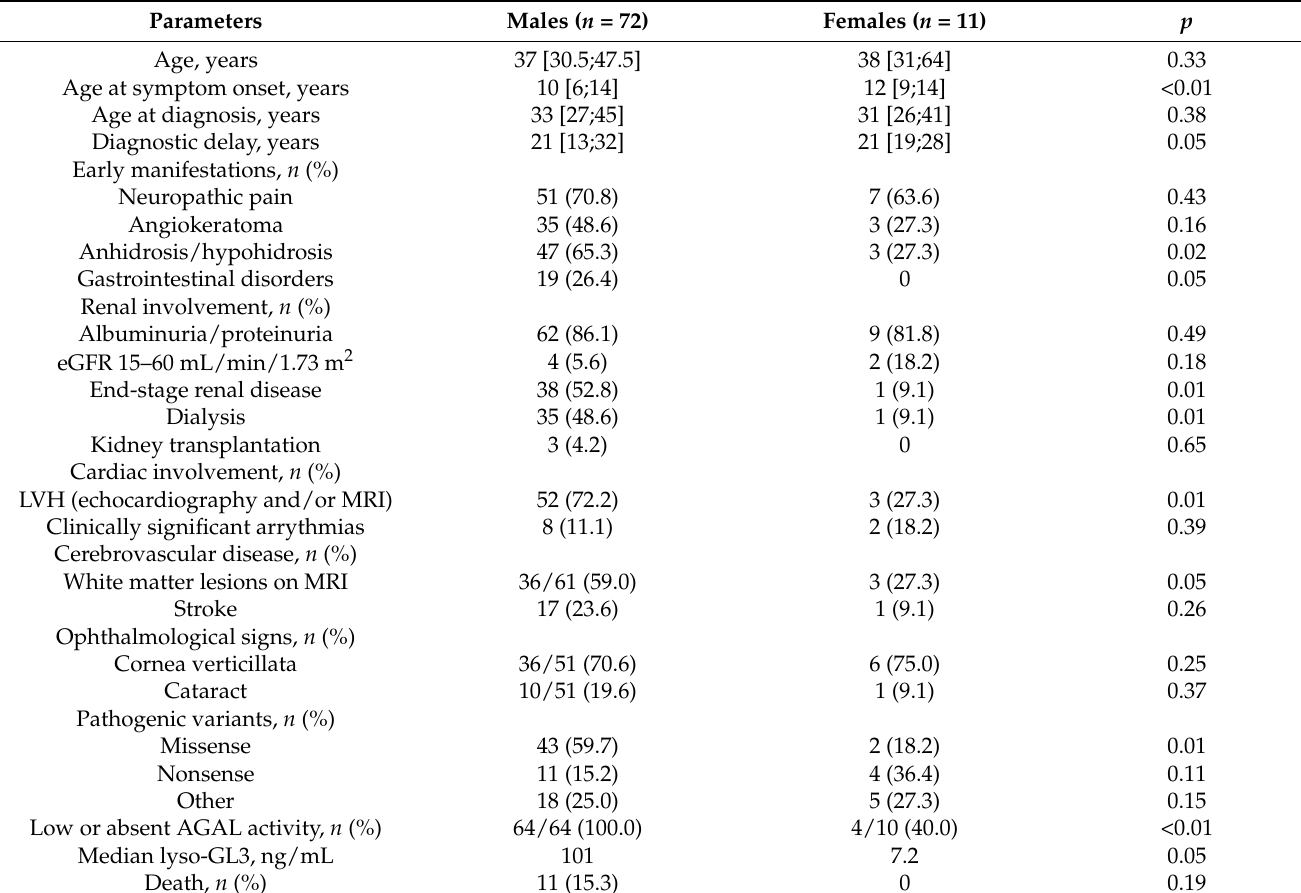
Table 1. Demographic and clinical characteristics of the 83 probands with Fabry